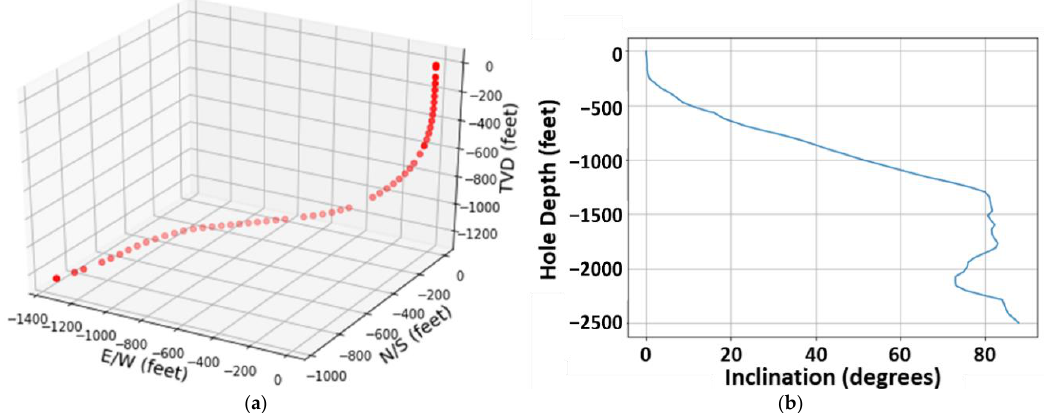
Figure 14. ( a ) Well trajectory ( b ) Well inclination profile (negative sign indicates downward depth into the sub-surface).